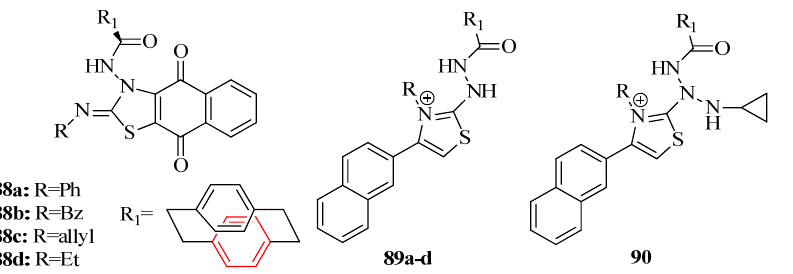
Figure 35. Structures of paracyclophanyl-thiazole hybrids.